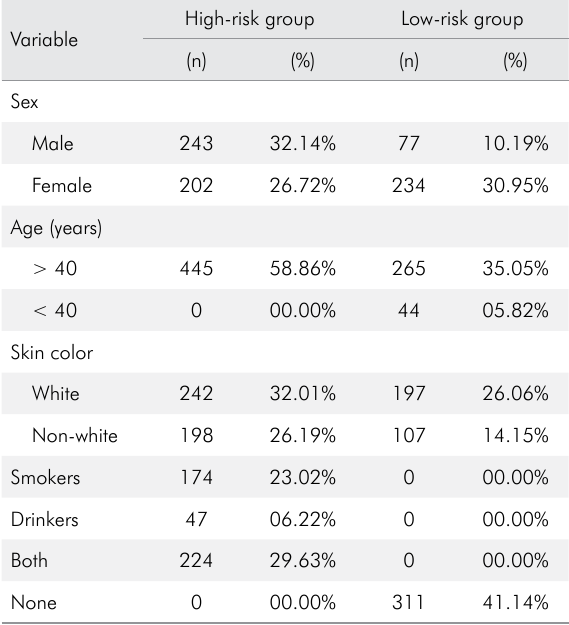
Table 1. Sociodemographic data per group of patients screened in Piracicaba, Brazil,